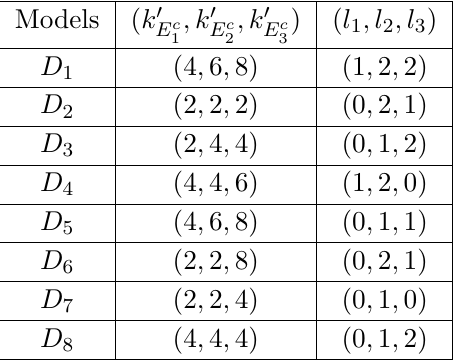
Table 6 . List of the charged lepton models D 1 , D 2 ,. . . , D 8 , where k 0 of the modular forms in the charged lepton Yukawa coupling. The left-handed lepton fields are assumed to be an A